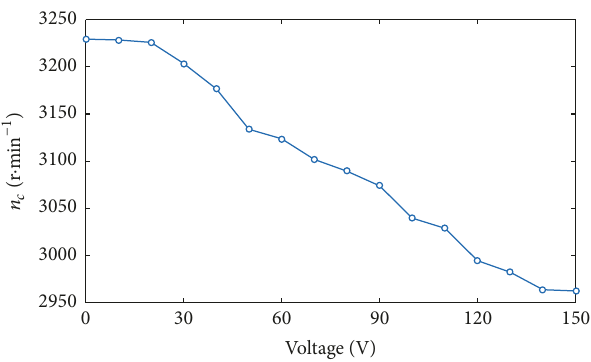
Figure 14: The critical speed of rotation 𝑛 𝑐 as a function of the control